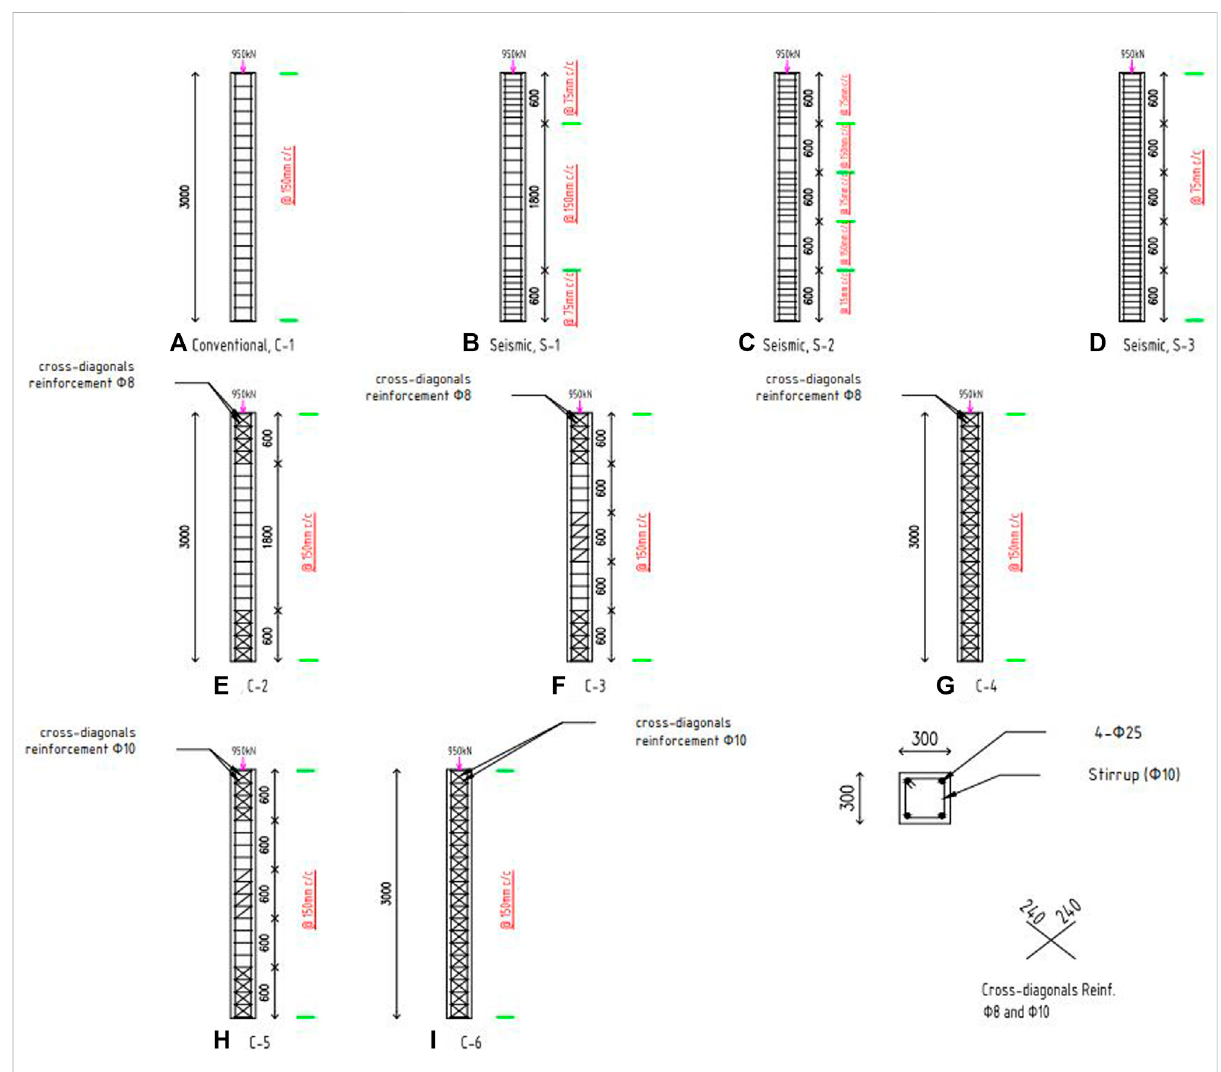
FIGURE 1 Dimensions (mm) and details of the